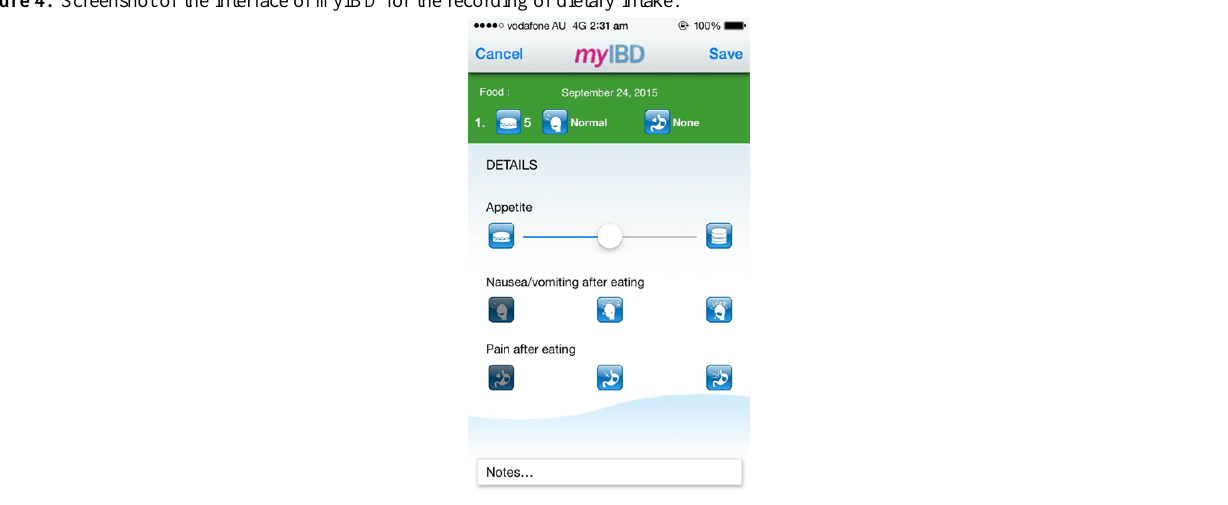
Figure 4. Screenshot of the interface of myIBD for the recording of dietary